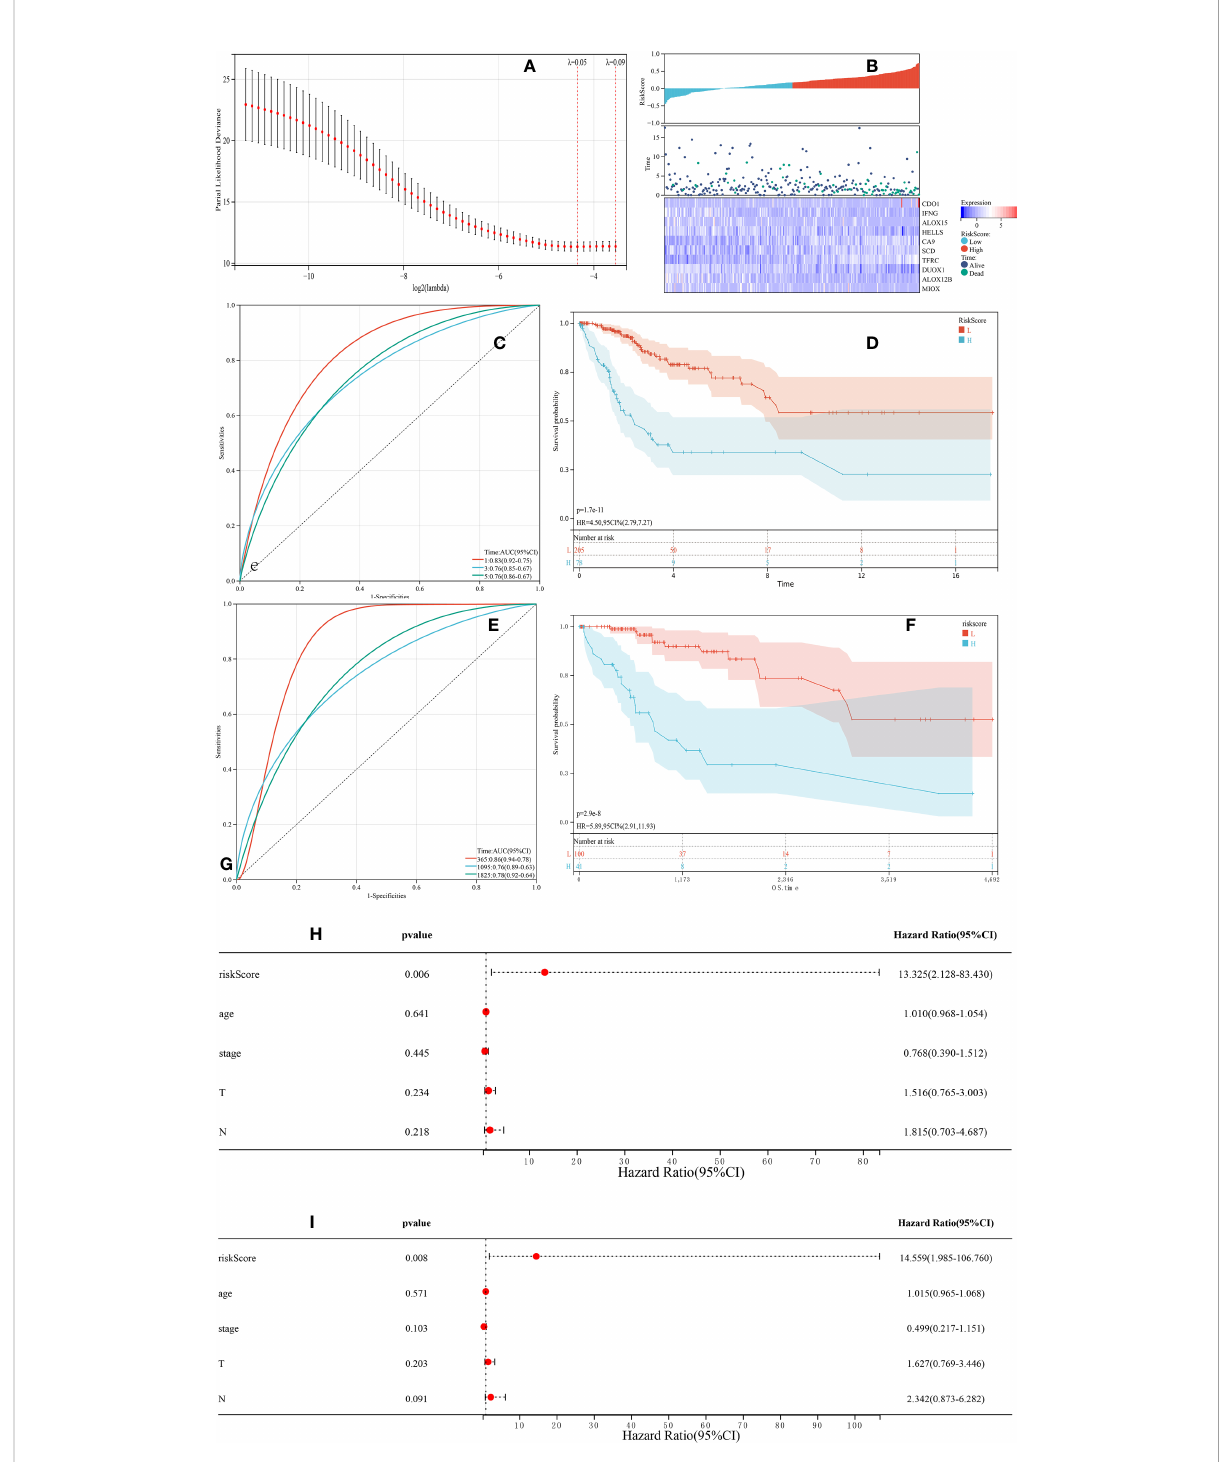
FIGURE 3 Synthetic analysis of the prognostic value of the ferroptosis-based risk signature. (A) The least absolute shrinkage with 10-fold cross-validation, by conducting candidate shrinkage to build the model. (B) Distribution of risk scores among endocervical adenocarcinoma samples and 10 gene risk scores and patient survival status. (C, E) Time-dependent receiver operating characteristic curves for survival prediction with area under the curve values in both The Cancer Genome Atlas (TCGA) training (C) and testing (E) cohorts. (D, F) Kaplan-Meier curves for the overall survival (OS) of patients in the high risk and low risk group in both the TCGA training (D) and testing (F) cohorts. (H, I) The univariate and multivariate connections of risk scores and other common clinical factors with